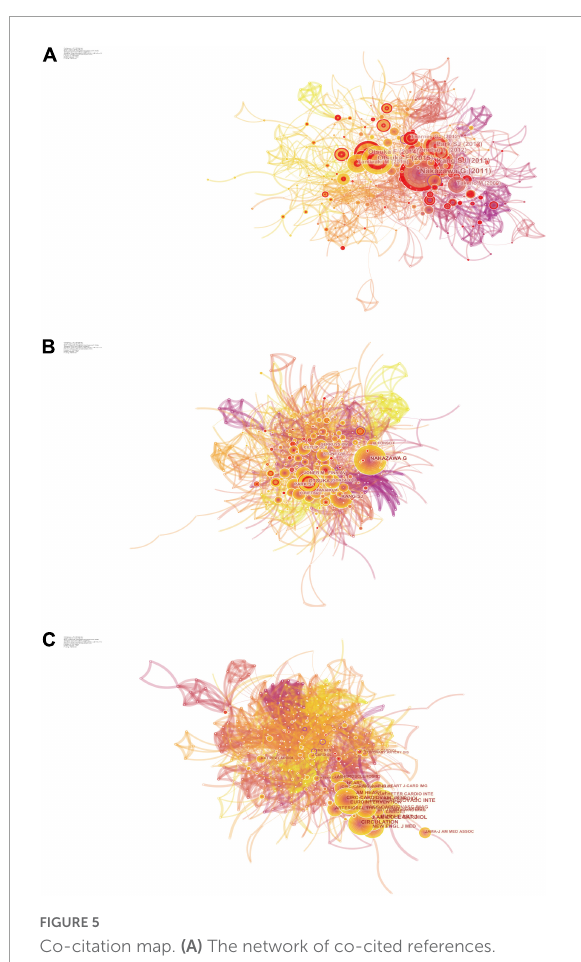
FIGURE5 Co-citation map. (A) The network of co-cited references. (B) The network of co-cited authors. (C) The network of co-cited